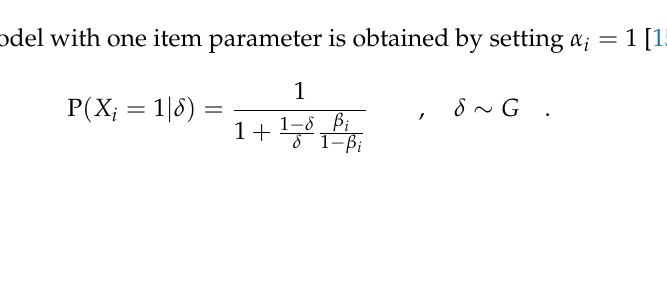
Figure 2. Item response functions for seven items of the LDS